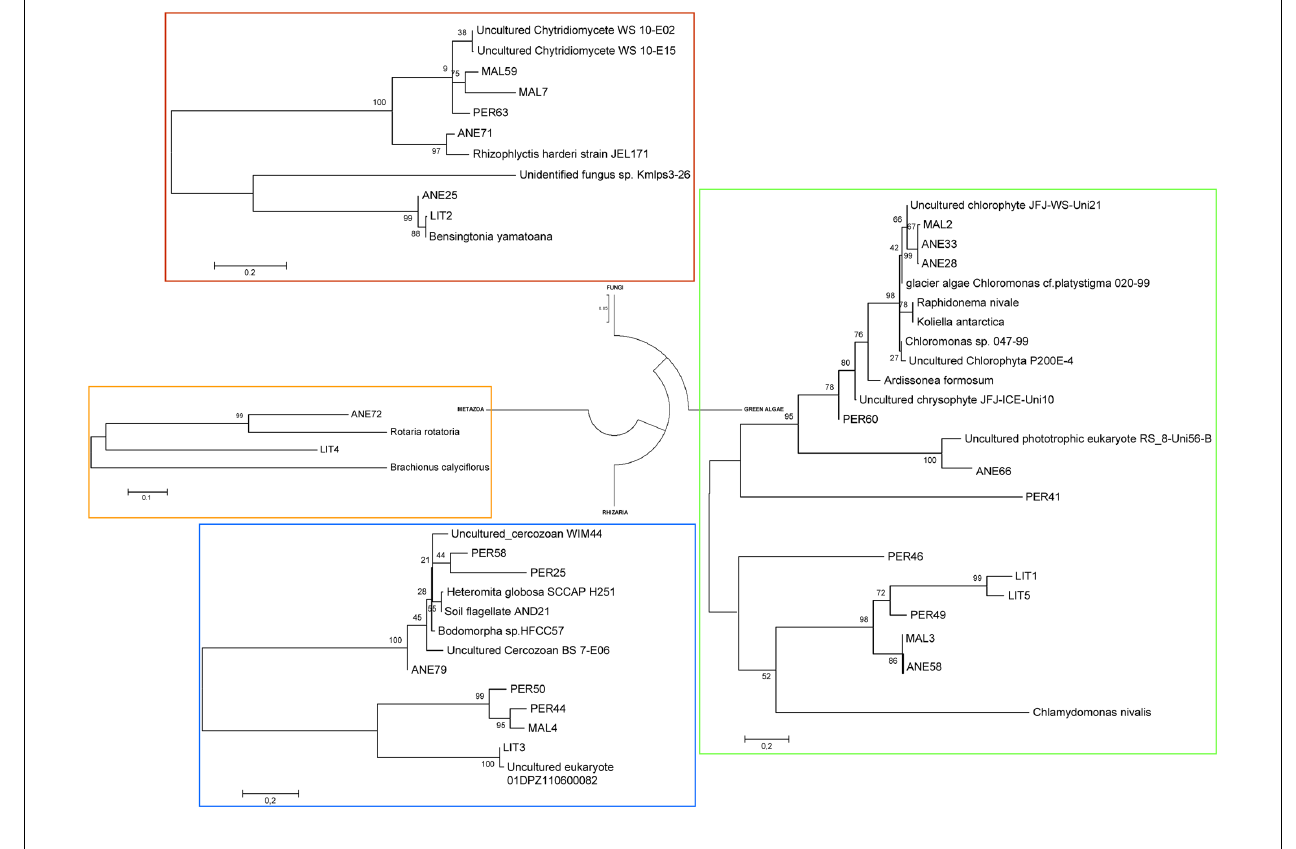
FIGURE 2 | Phylogenetic analysis of microbial community DNA in ice samples. Consensus phylogenetic tree derived from 18S rRNA gene sequence data showing the four groups of microbial eukaryotes found in Pyrenean glaciers.The distance corresponding to one base change per